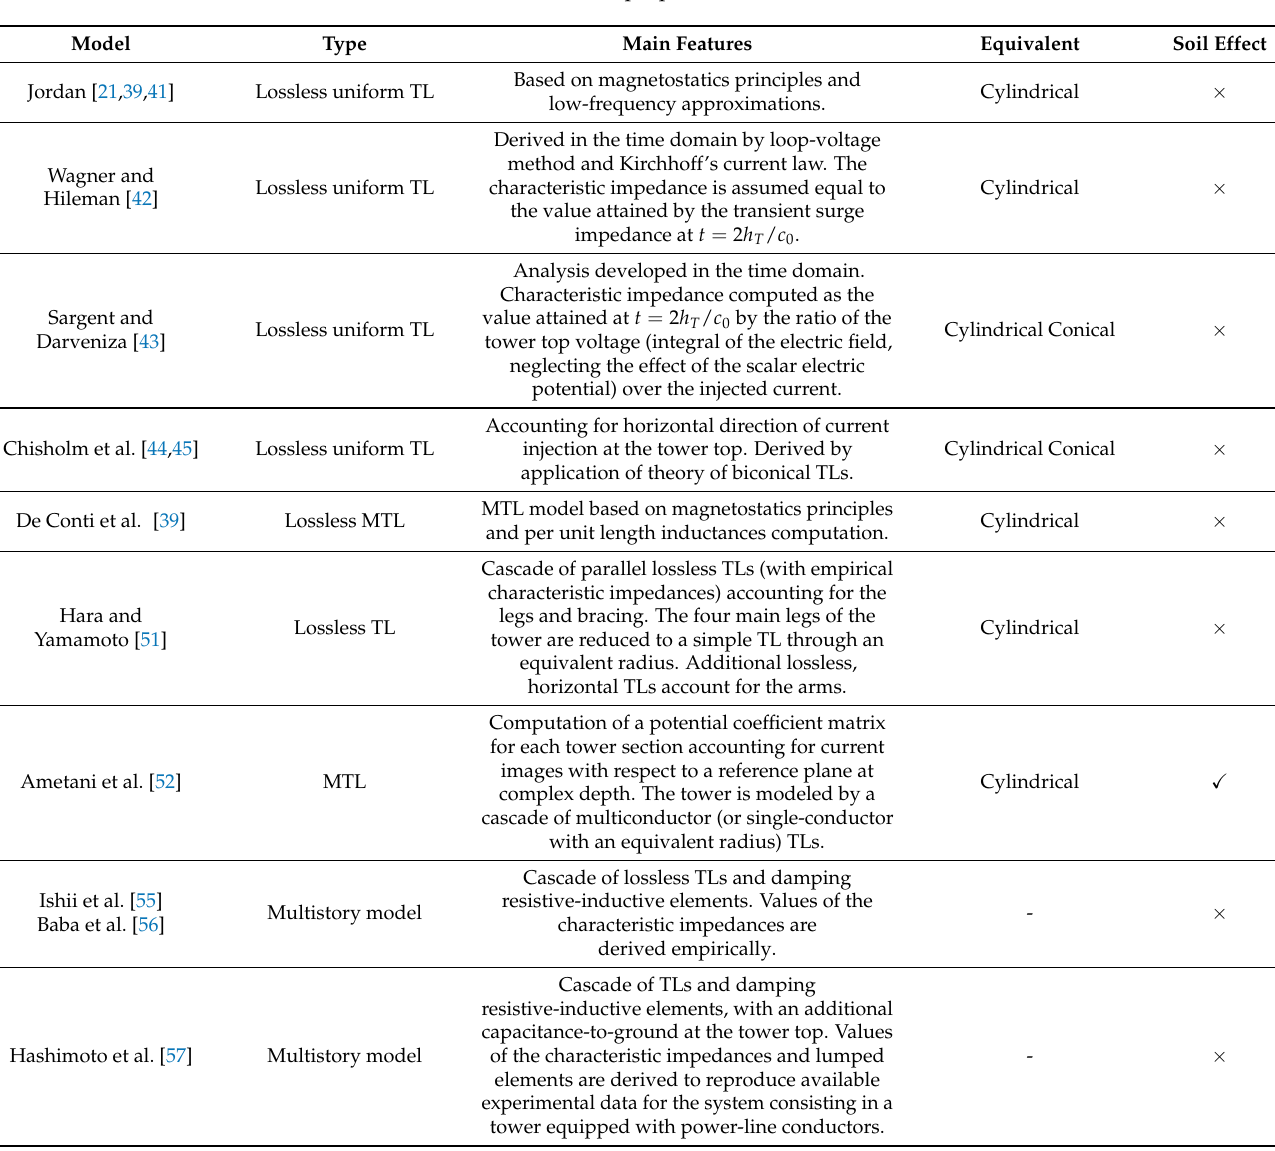
Table 2. Relevant tower models proposed in the literature